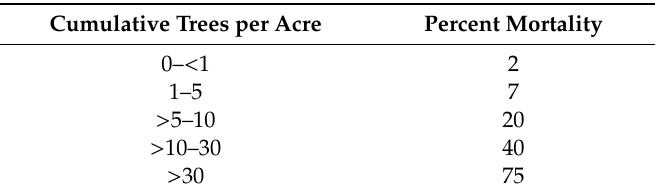
Table 1. Conversion factors from the FHAAST method between cumulative trees per acre and percent mortality for United States Forest Service (USFS) Region 1,